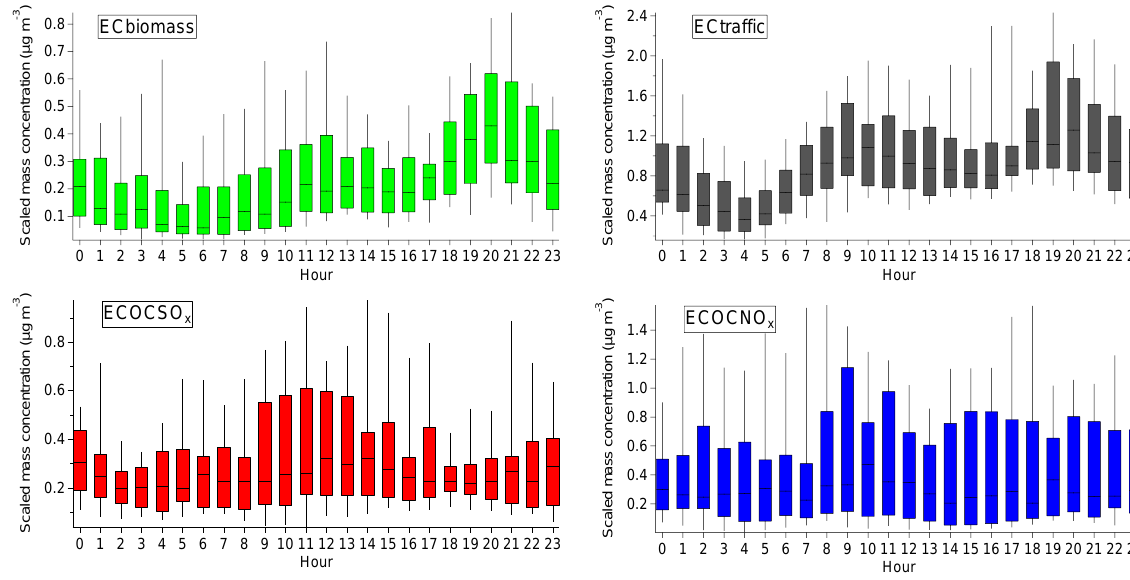
Fig. 2. Box plots of diurnal trends (local time) of scaled mass concentration for the 4 ATOFMS EC classes ( n = 27). Median, 75th percentile and 90th percentile are denoted by the solid line, box and whisker